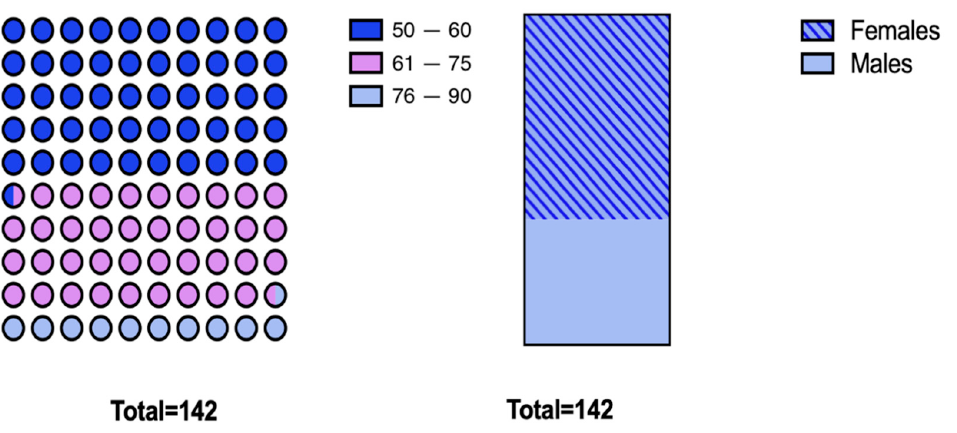
Figure 1. Graphic representation of the age and gender structure of the study group. Table 1. Characteristics of the study group showing the relationship of the observed diseases to the gender of the respondents. Diabetes was statistically significantly more common in men 37% (n = 53) than in women 19.3% (n = 27). Women were significantly more likely to report complaints of depression and neurosis 26.1% (n = 37) compared to 7.4% (n = 10) of men. Detailed data are shown in Table 1.